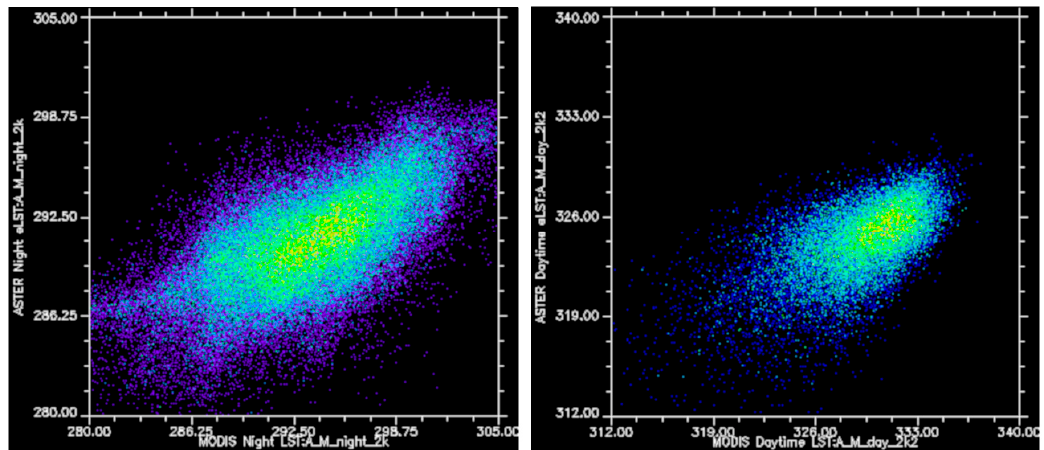
Figure 10 . Scatter plots for the spatially-convolved ASTER eLST datasets and MODIS derived LST. Correlation coefficients are 0.861 for nighttime (left) and 0.697 for the daytime (right) datasets.